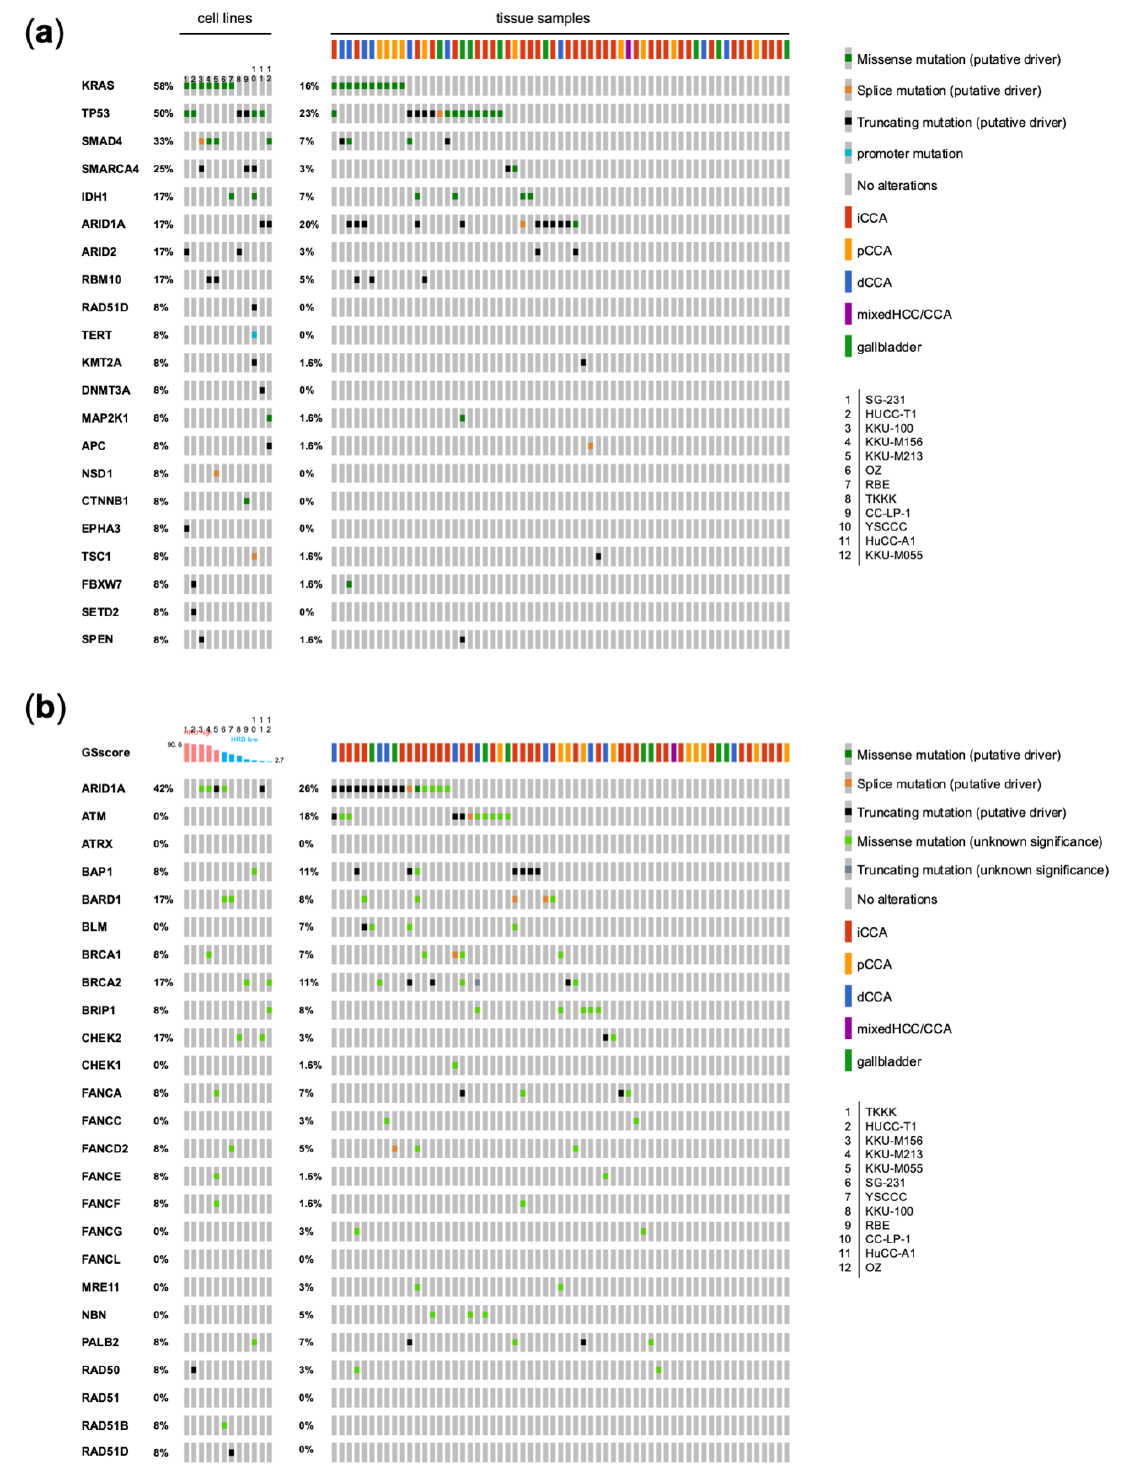
Figure 1. ( a ) Oncoprint plot displaying putative driver mutations detected in cell lines and CCA (cholangiocarcinoma) tissue samples with the frequency of occurrence. ( b ) Oncoprint plot including mutations of unknown significance in a set of homologous DNA repair associated genes. Indication of genomic scar score (GSscore) as determined by the AmoyDx ® HRD Focus Panel for cell lines. Abbreviations: iCCA, intrahepatic cholangiocarcinoma; pCCA, perihilar cholangiocarcinoma; dCCA, distal cholangiocarcinoma; mixed HCC/CCA, mixed hepatocellular cholangiocarcinoma; gallbladder, gallbladder carcinoma; HRD, homologous DNA repair deficiency.